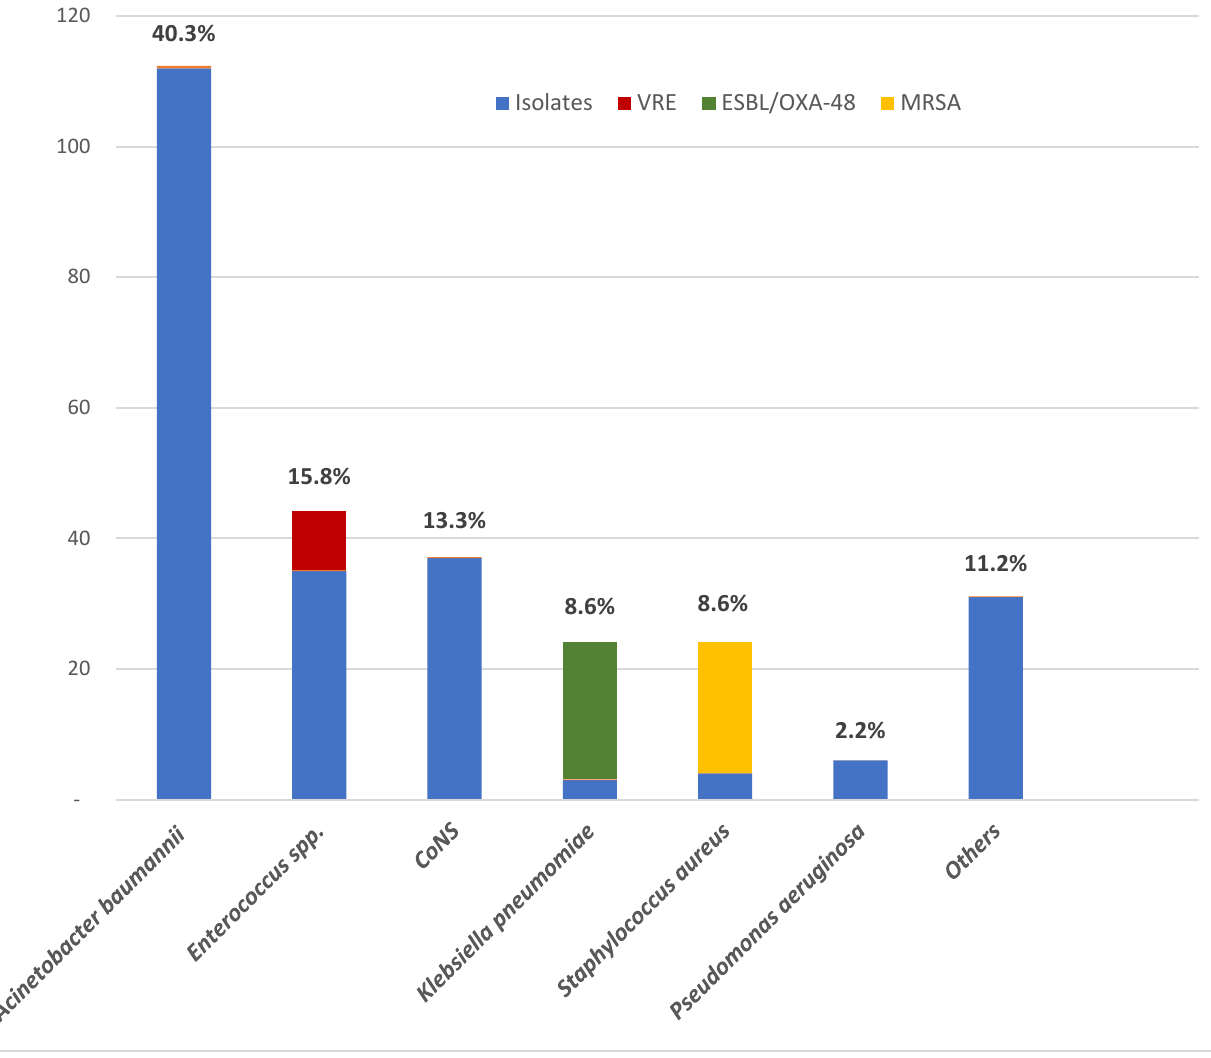
Figure 1. The most common etiological agents of healthcare-associated bloodstream infections in the COVID-19 intensive care unit at the Dubrava University Hospital during the second wave of the